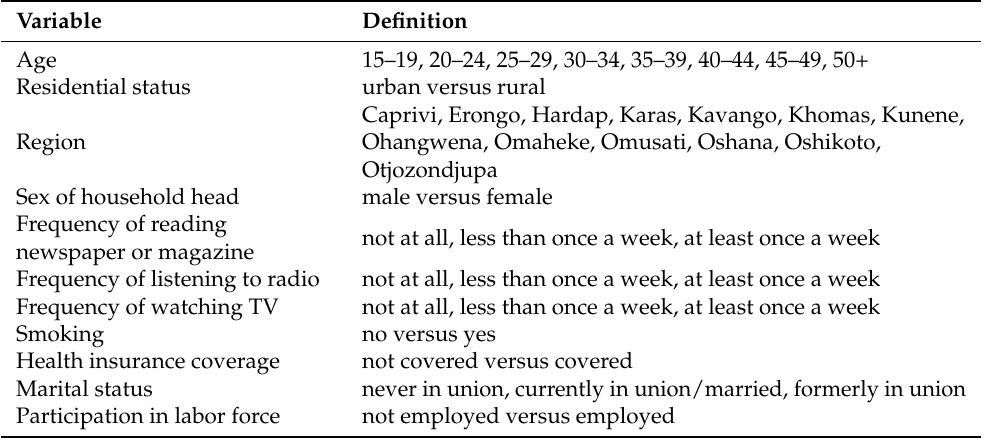
Table 1. Explanatory factors for HIV prevalence among women in